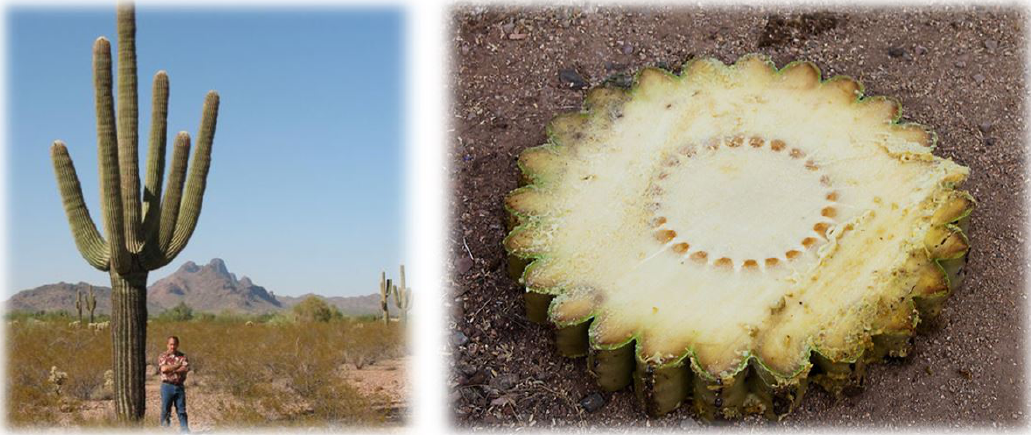
Figure 1. The Giant Saguaro Cactus and its cross